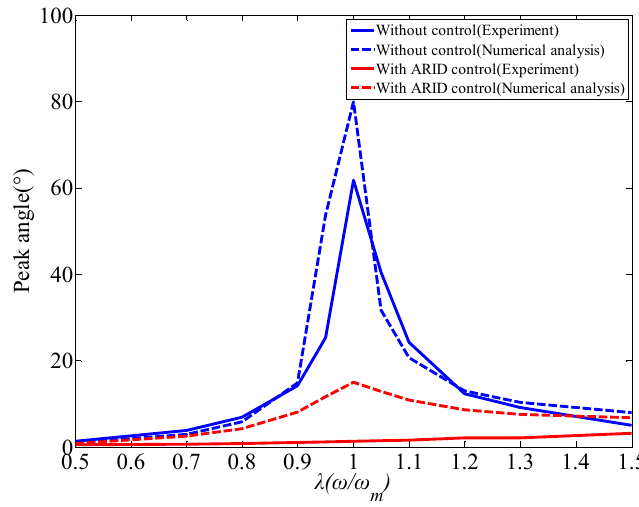
Figure 12. Peak swing angle of experiment and numerical analysis.